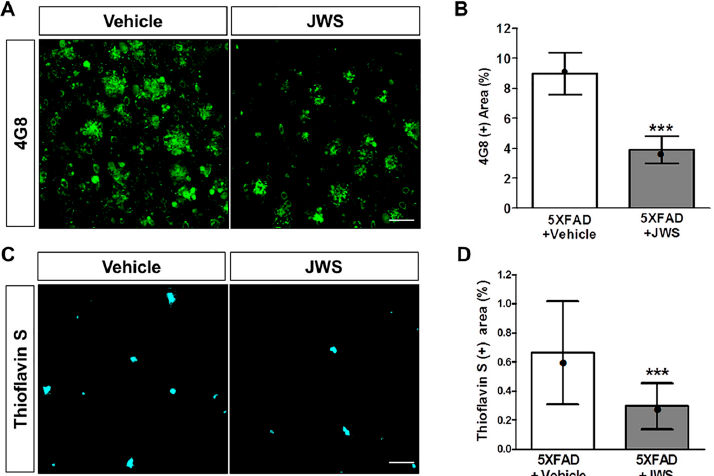
Figure 2. Histochemical evidence for decreased A β accumulation in the deep cortical layers in the brain of 5 five familial Alzheimer's disease mutations (5XFAD) mice. Representative images of brain sections